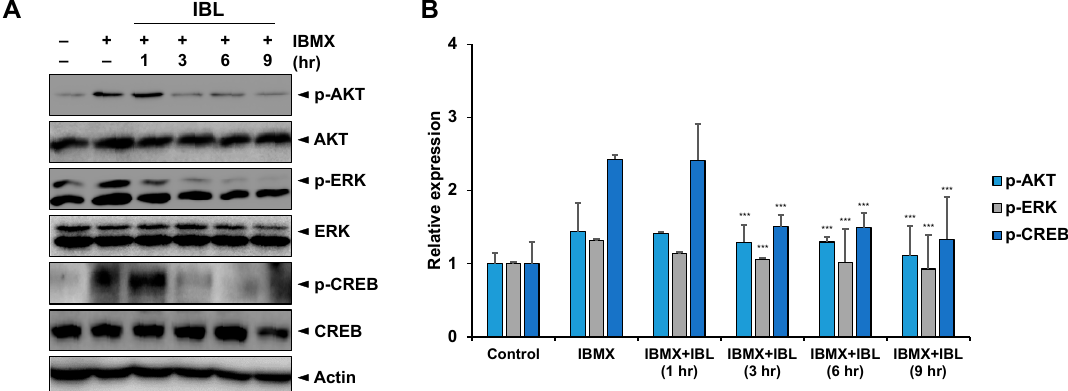
Figure 7. ( A ) Effects of IBL on the protein expressions of p-AKT, p-ERK, and p-CREB in B16F10 cells. B16F10 cells were pre-treated with 100 µM IBMX for 48 h and then exposed to IBL for the indicated time periods. Whole cell lysates were subjected to Western blot analysis using specific antibodies against phospho-AKT, AKT, phospho-ERK, ERK, phospho-CREB, and CREB. Equal protein loading was confirmed by actin. ( B ) Bar graphs of the relative expressions of phospho-AKT, phospho-ERK, and phospho-CREB. The expression levels were normalized to that of actin. Values are represented as means ± SEM. ( n = 3, *** p ≤ 0.001).